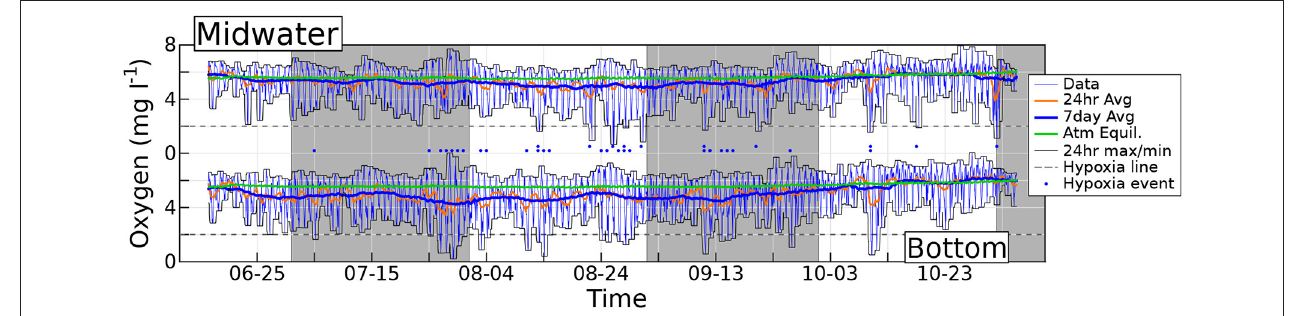
FIGURE 2 | Measured hourly dissolved O 2 concentration (thin blue lines) at the bottom and midwater sensors. Orange lines denote daily centered running averages of O 2 , and thick blue lines are weekly averages. Thin black lines show the maxima and minima of O 2 within the preceding 24 h. The green solid line is the O 2 air saturation concentration. Horizontal dashed lines are traced at the hypoxia threshold (2 mg l − 1 ), and dots mark the evenings when hypoxia occurs. Gray shading demarcates separate months.